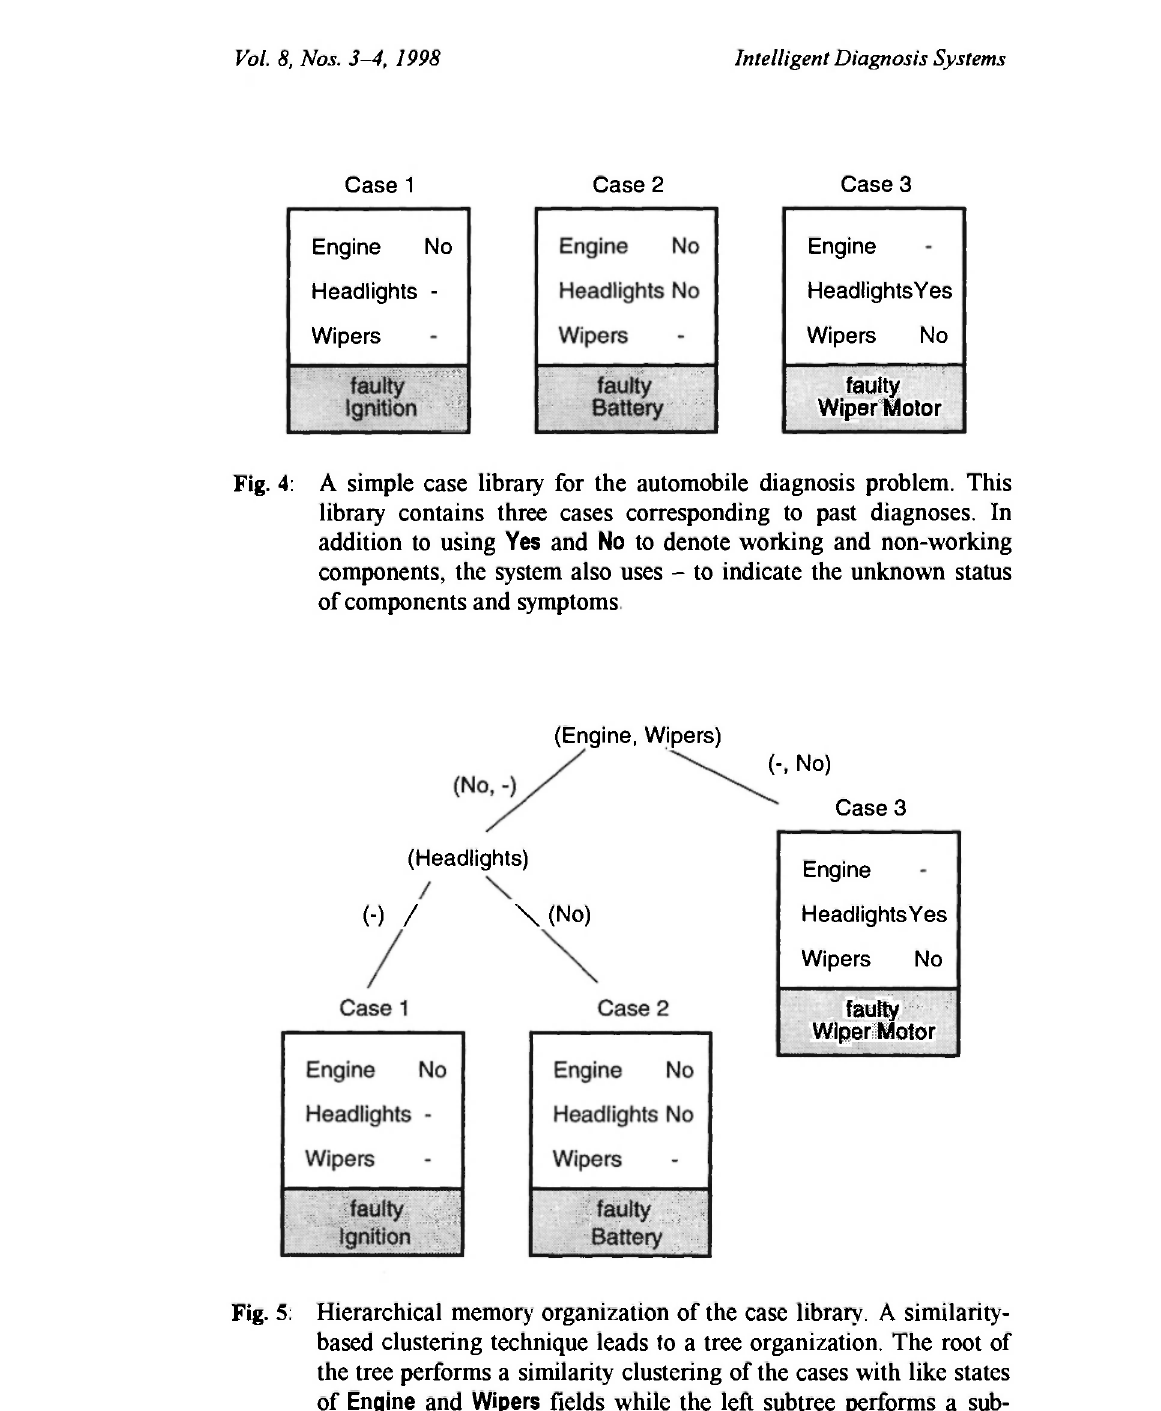
Fig. 5: Hierarchical memory organization of the case library. A similarity- based clustering technique leads to a tree organization. The root of the tree performs a similarity clustering of the cases with like states of Engine and Wipers fields while the left subtree performs a sub- clustering based on the state of the Headlights. This results in a two- level